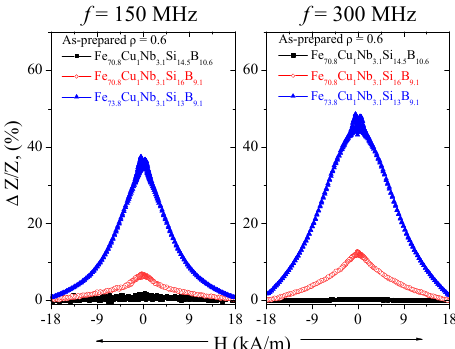
Figure 8. Δ Z/Z (H) dependences of as-prepared Fe 70.8 Cu 1 Nb 3.1 Si 16 B 9.1 , Fe 70.8 Cu 1 Nb 3.1 Si 14.5 B 10.6 , and Fe 73.8 Cu 1 Nb 3.1 Si 13 B 9.1 Finemet glass-coated microwires with the same ρ -ratio = 0.6 measured at frequencies of 150 and 300 MHz . Reproduced from reference [47], Figure 5.